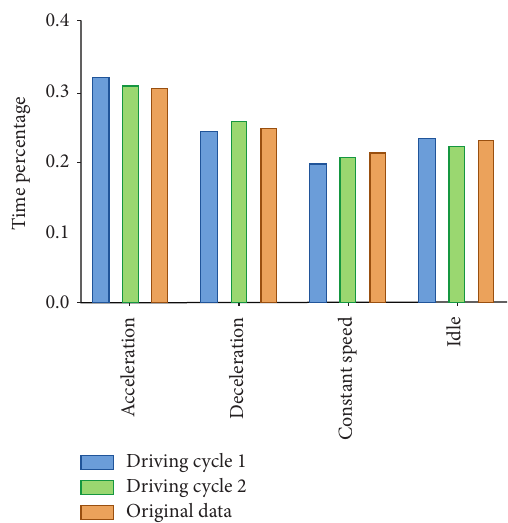
Figure 13: Distribution of driving modes under the two driving cycles.